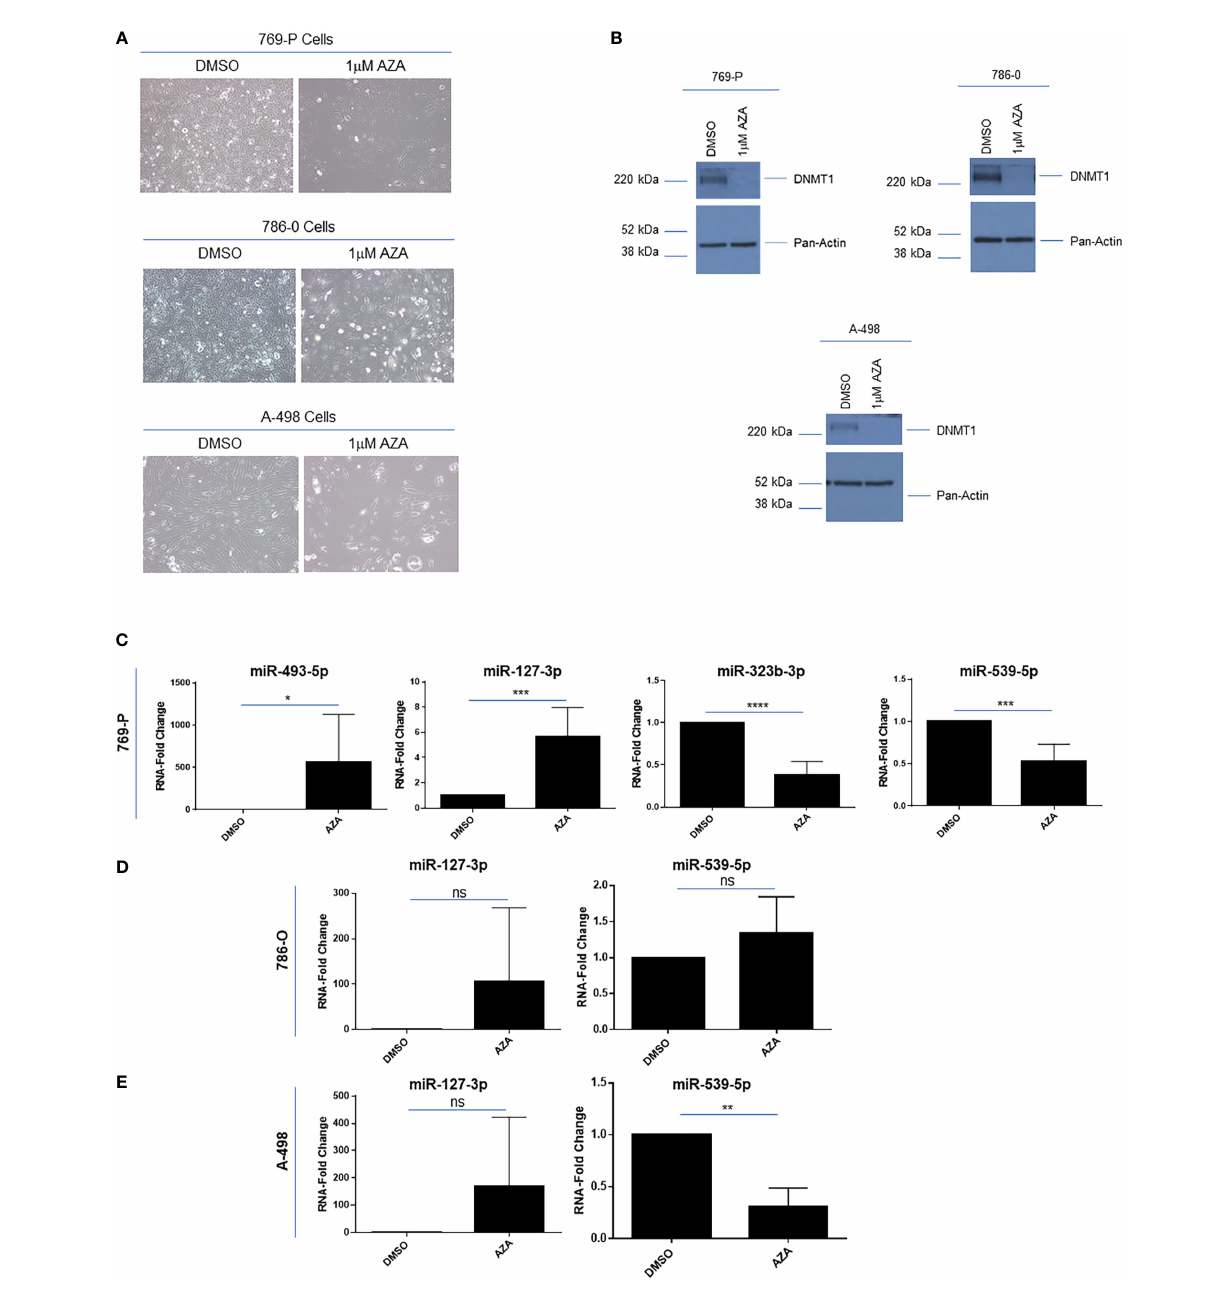
FIGURE 5 Epigenetic regulation of 14q32 miRNAs in ccRCC cell lines. (A) Light microscopic images of 769-P, 786-O, and A-498 cells treated with 1 m M Azacytidine (AZA) for 120 hours at 20x magni fi cation. (B) Protein lysates were obtained from AZA-treated ccRCC cells followed by western blotting using the antibodies shown. (C) qPCR analyses of miR-493-5p, miR-127-3p, miR-323b-3p, and miR-539-5p (normalized to RNU48) in DMSO- and AZA-treated 769-P cells. The data represents a composite of three independent replicates. (D) qPCR analyses of miR-127-3p and miR-539-5p in DMSO- and AZA-treated 786-O cells. The data represents a composite of three independent replicates. (E) qPCR analyses of miR-127-3p and miR- 539-5p (normalized to RNU48) in DMSO- and AZA-treated A-498 cells. The data represents a composite of three independent replicates. ns, not signi fi cant; * p -values ≤ 0.05; ** p -values ≤ 0.01; *** p -values ≤ 0.001; **** p -values ≤